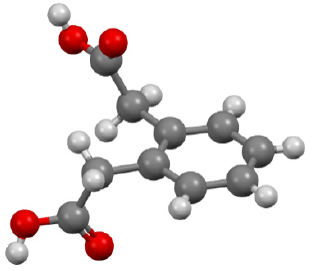
Figure 1. Scheme of 1,2-phenylenediacetic acid.